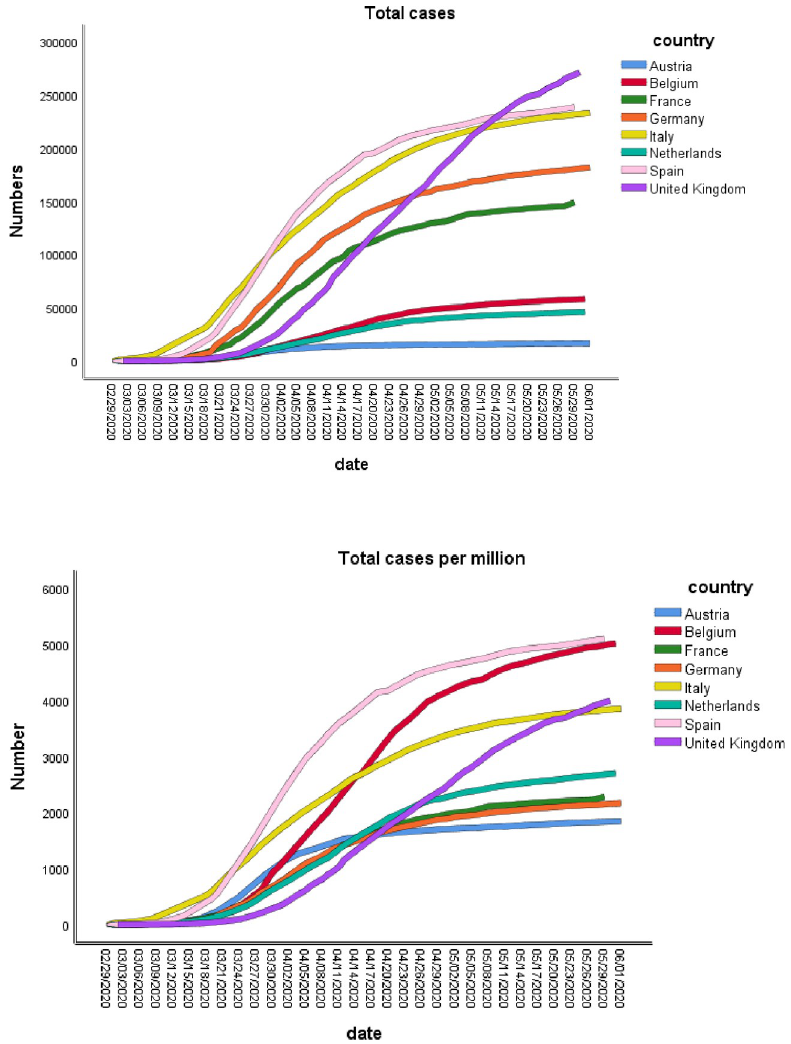
Fig 1. Cases over time. Lockdown dates: Austria = 2020-03-16, Belgium = 2020-03-18, France = 2020-03-17, Germany = 2020-03-23, Italy = 2020-03-09, Netherlands = 2020-03-23, Spain = 2020-03-14, United Kingdom = 2020-